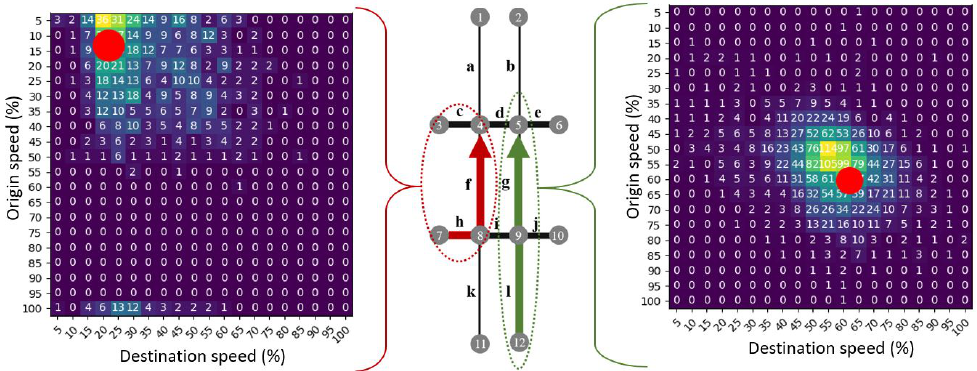
Figure 2. Transitions ( center ), congested STM ( left ), and normal traffic STM ( right ) examples on a simple road